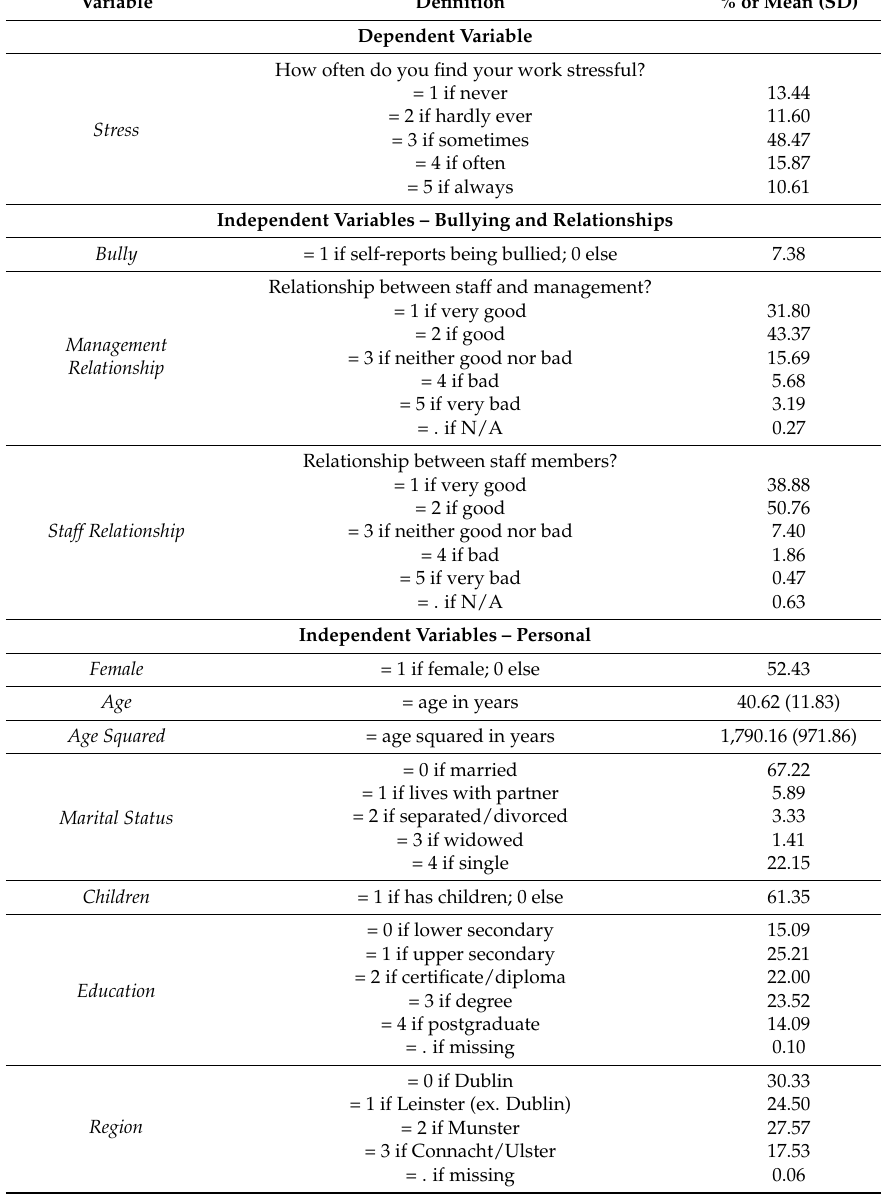
Table 1. Variable definitions and sample descriptive